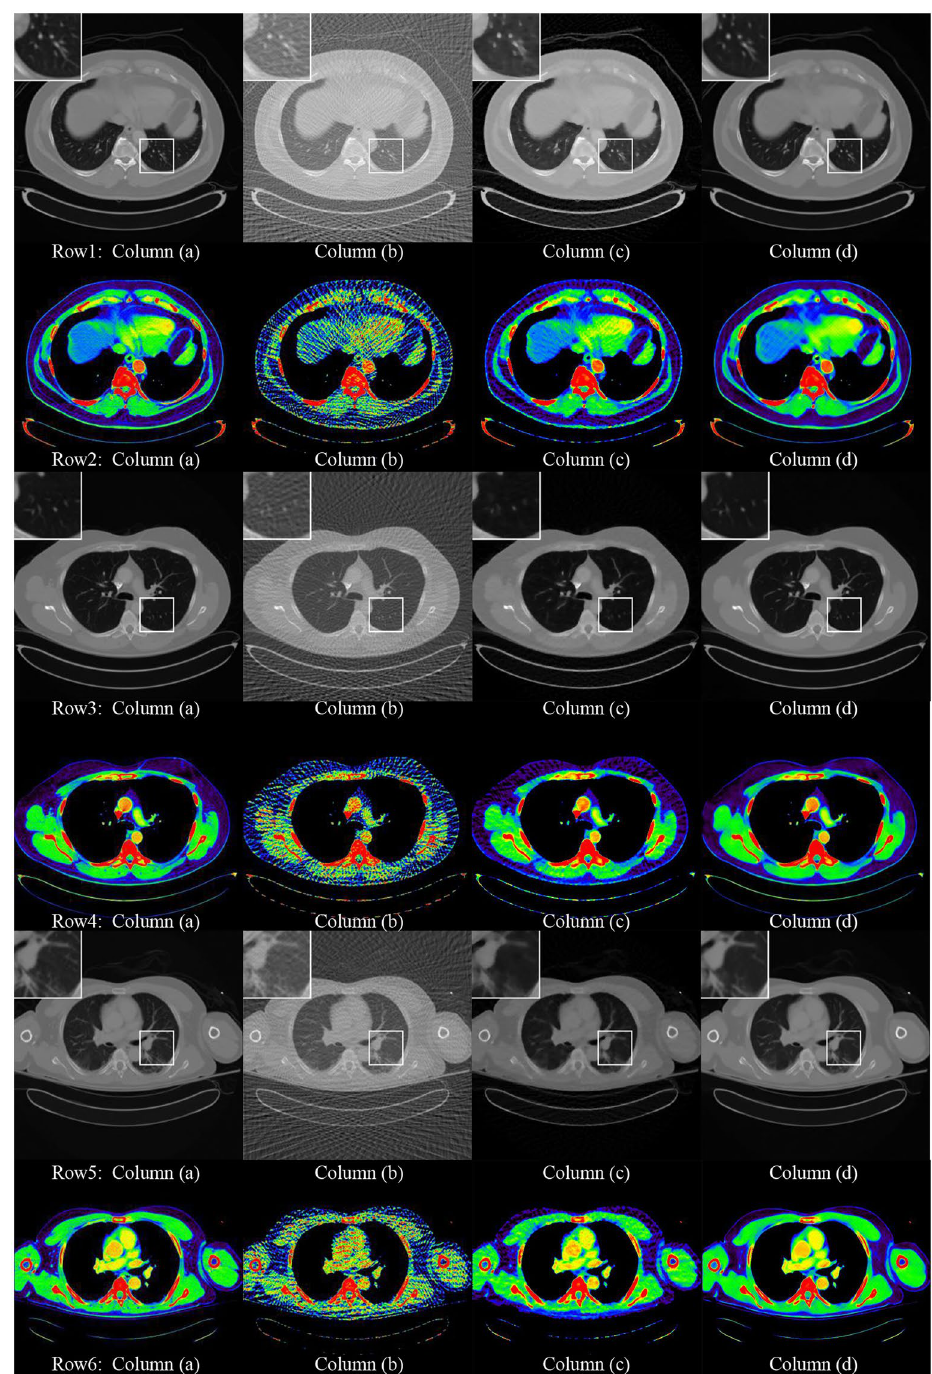
Figure 1. The 512 * 512 CT images reconstructed by 120 projection views. Column ( a ) shows the reconstruction by the FBP method from the full projection views. Column ( b ) shows the reconstruction by the FBP method from the sparse projection views. Column ( c ) shows the reconstruction by the ADS-POCS method from the sparse projection views. Column ( d ) shows the reconstruction by the proposed method. All images display in the same window at row 1, 3 and 5. In order to compare the CT value with different reconstruction method, we use 2D atlas to display. The result is shown in row 2, 4 and